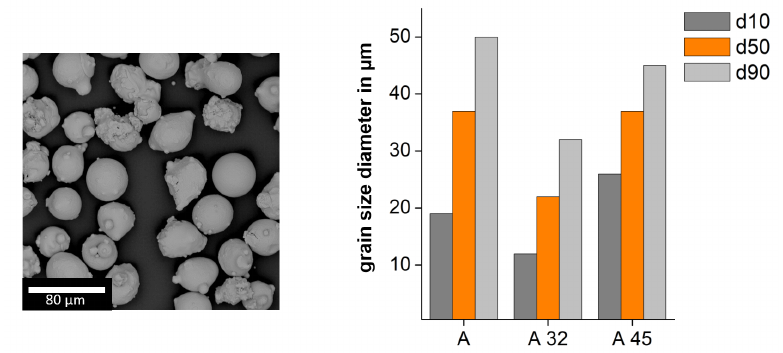
Figure 2. SEM images of Powder A ( left ) and particle size distribution of powder batch A, A32 and A45 ( right ).